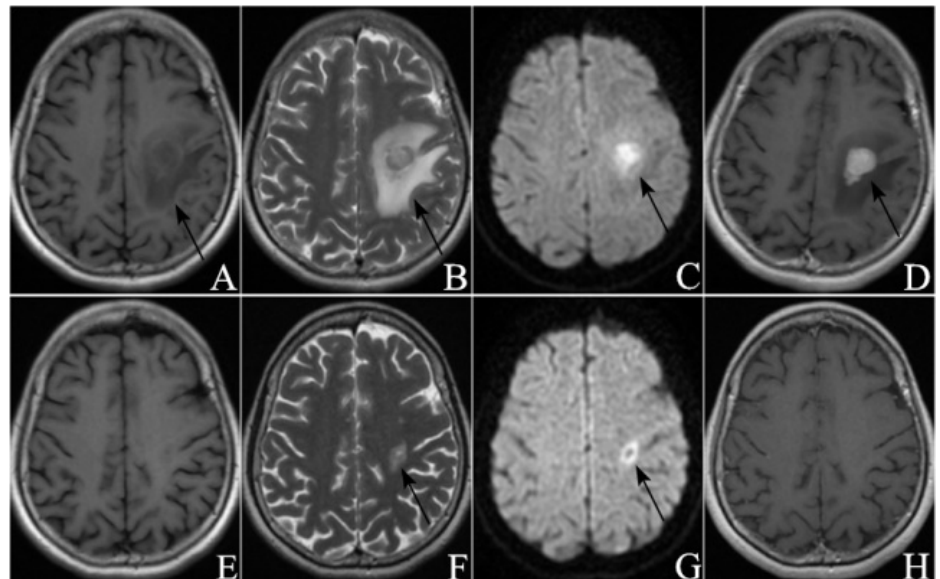
Figure 2. A sixty-five-year-old male PCNSL patient received consolidation WBRT after initial MTX